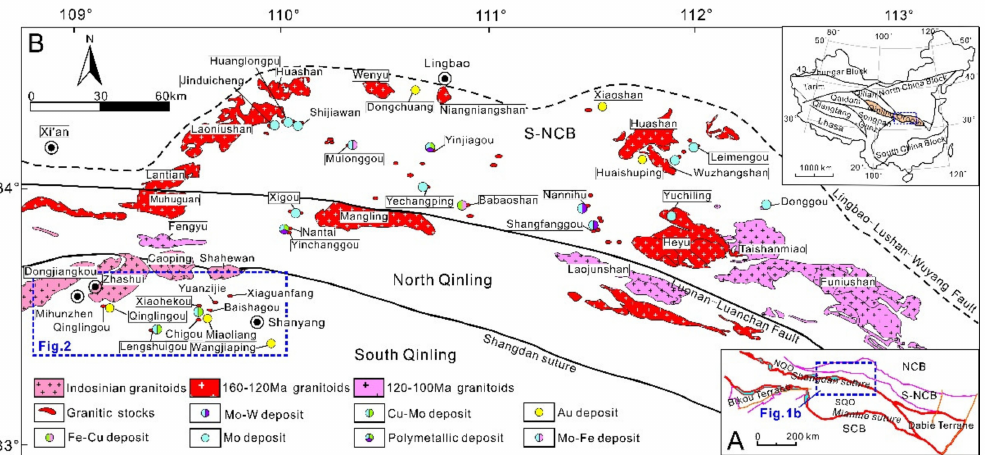
Figure 1. Sketch map showing the location and major tectonic units of the Qinling Orogen, central China ( A ); Geological map of the Qinling Orogen, showing the distribution of the Mesozoic granitoids and major deposits ( B )